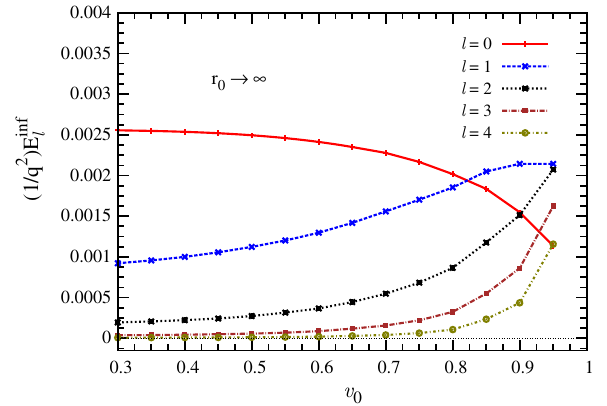
Fig. 5 Numerical estimates of the emitted energy radiated to infin- ity, E inf , as a function of v 0 for multipole numbers l = 0 , 1 , 2 , 3 , 4, l obtained from Eq. (28)